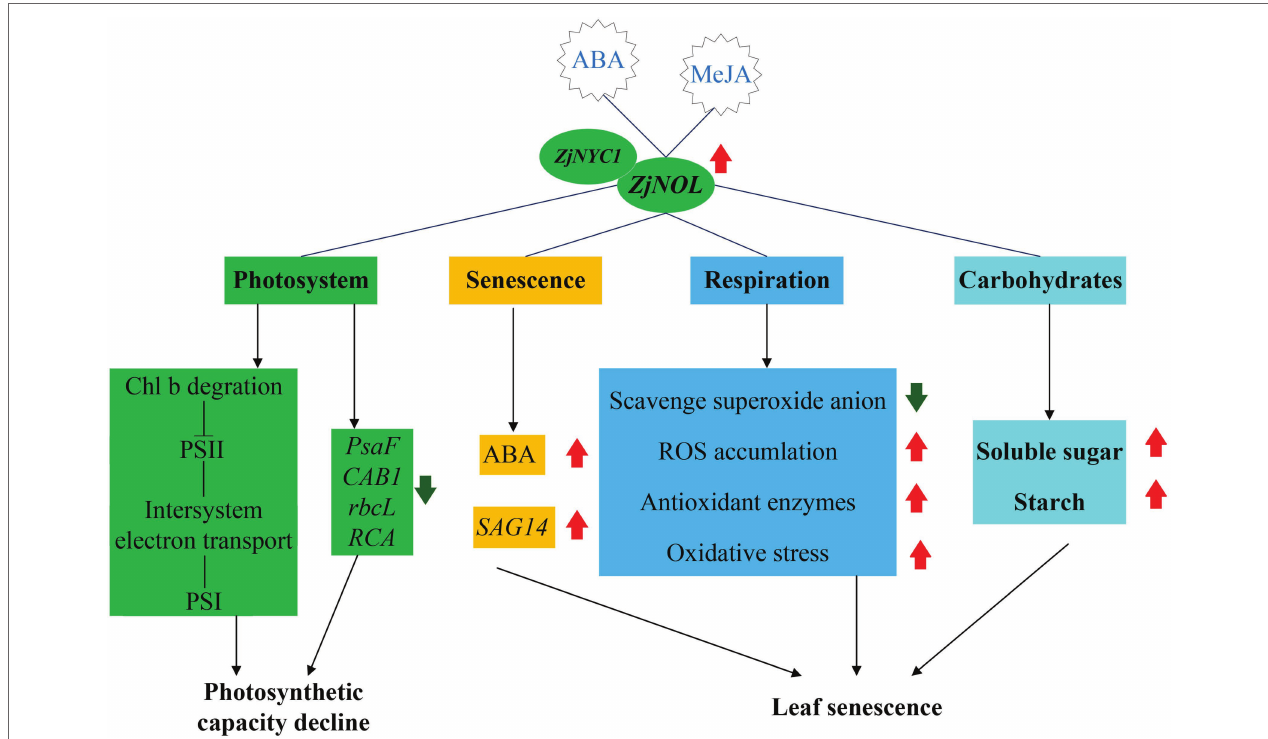
FIGURE 9 | A proposed working model of ZjNOL in regulating photosynthesis and